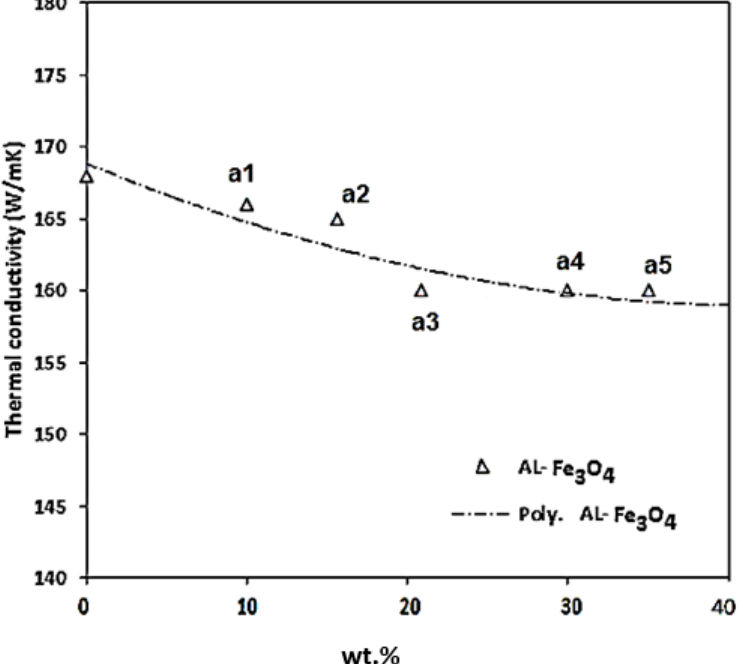
Figure 18. The effect of different weight percentages of Fe 3 O 4 on the thermal conductivity of Al-Fe 3 O 4 composites at ambient temperature.